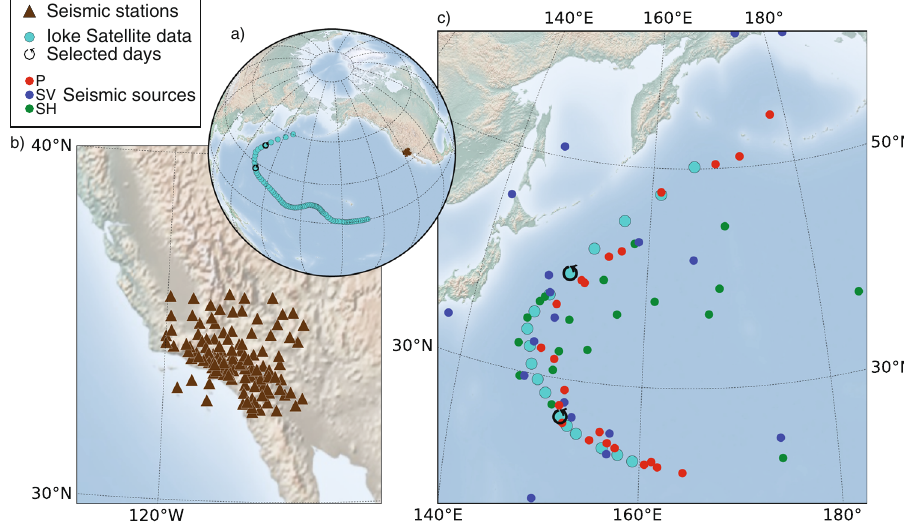
Fig. 1 Typhoon Ioke, seismic stations, and associated body-wave sources. a Satellite track of typhoon Ioke (cyan) and Southern California stations (brown). b Zoom over the Southern California seismic stations used in this study for locating the sources of typhoon Ioke. c Locations of body-wave seismic sources in the 4 – 6 s period band (P-wave sources are in red, SV-wave sources in blue, and SH-wave sources is green). The two circled arrows in panels a and c mark the two locations of the typhoon studied in this